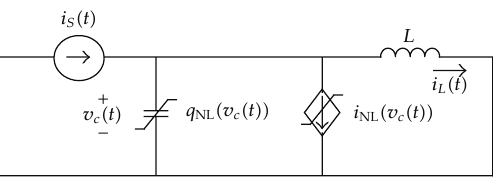
Figure 1: Nonlinear dynamic circuit